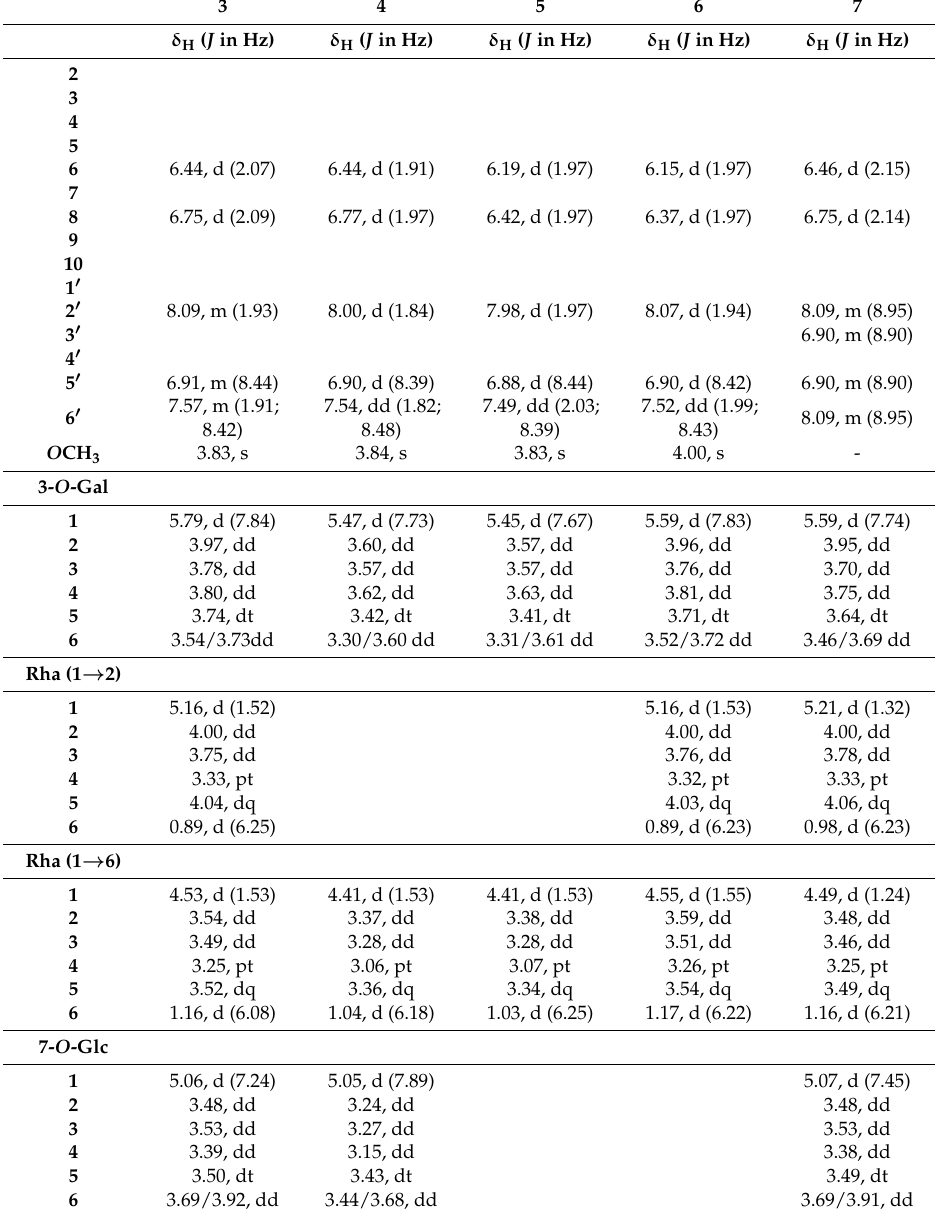
Table 3. 1 H-NMR assignments (600 MHz) of compounds 3 – 7 δ H (ppm), multiplicity ( J in